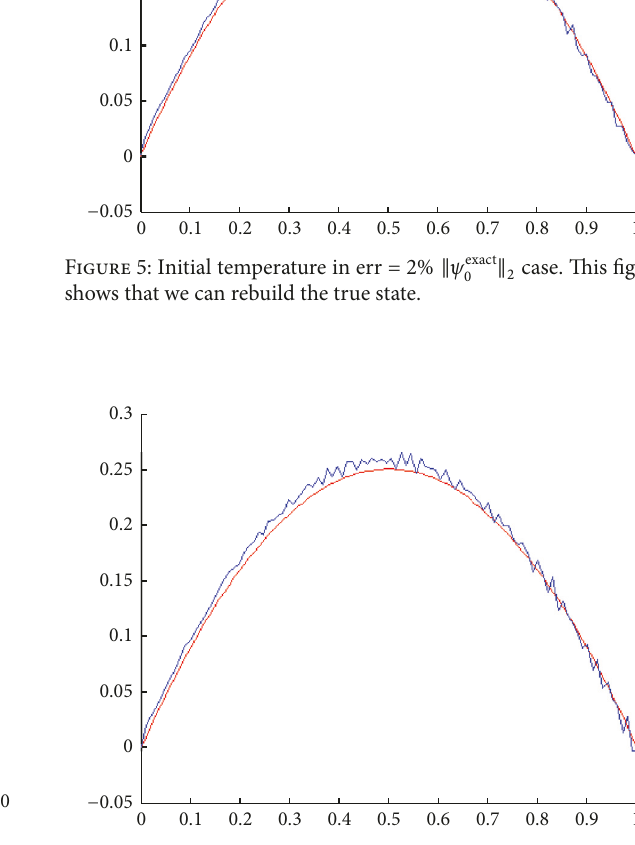
Figure 6: Initial temperature in err = 5% ‖𝜓 exact 0 ‖ 2 case. The recon- structed initial condition is not far from the true state.